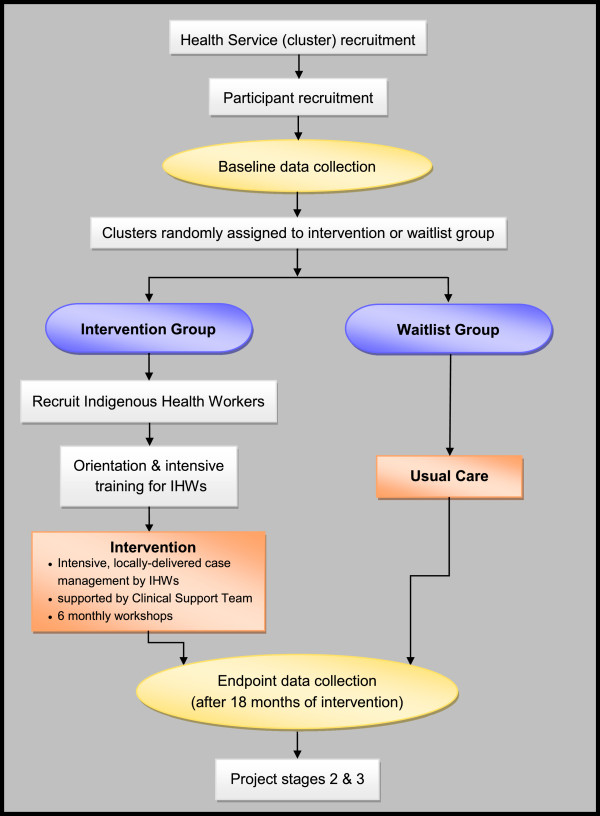
Flowchart for a cluster randomised controlled trial of family-centred chronic care delivered by IHWs to Indigenous clients.